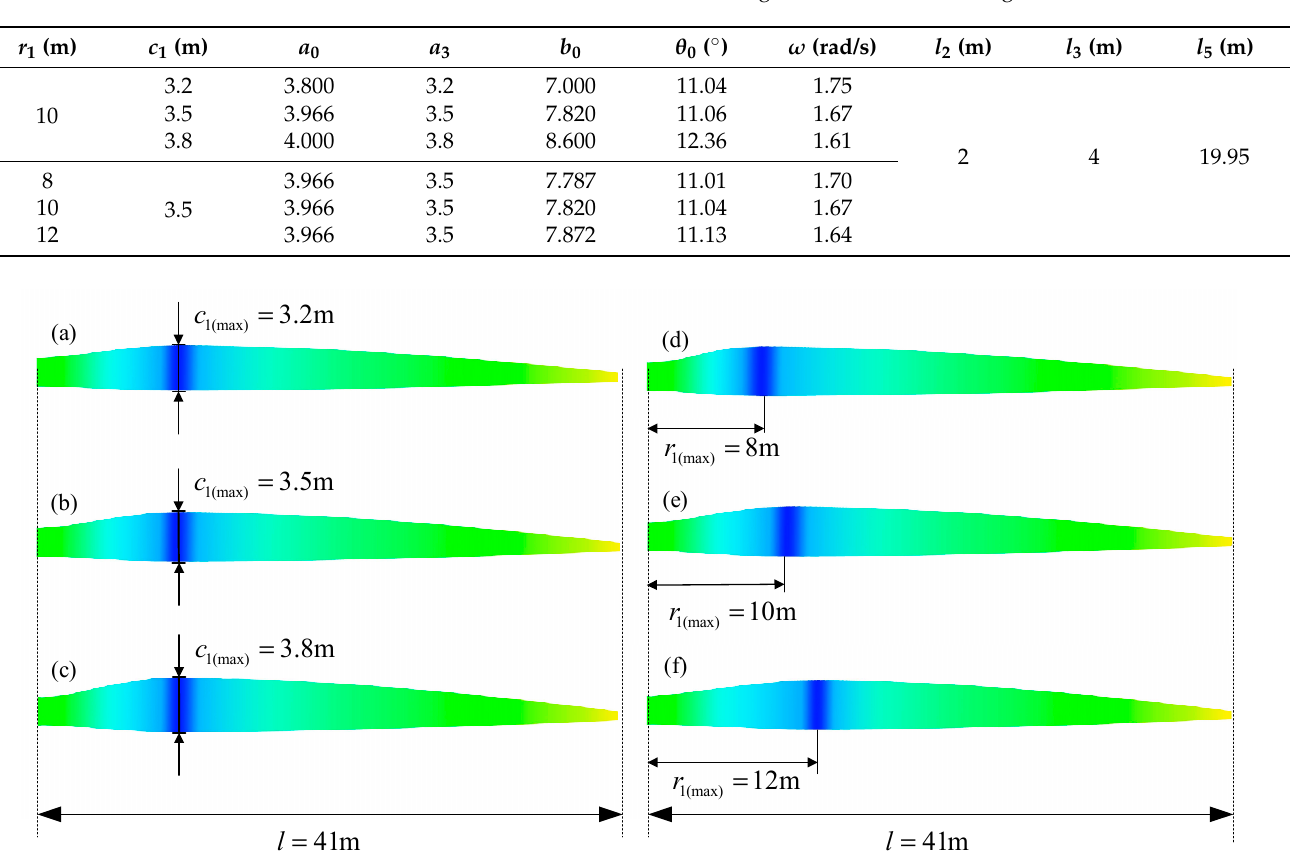
Table 3. The effect of the maximum chord length and its location change.